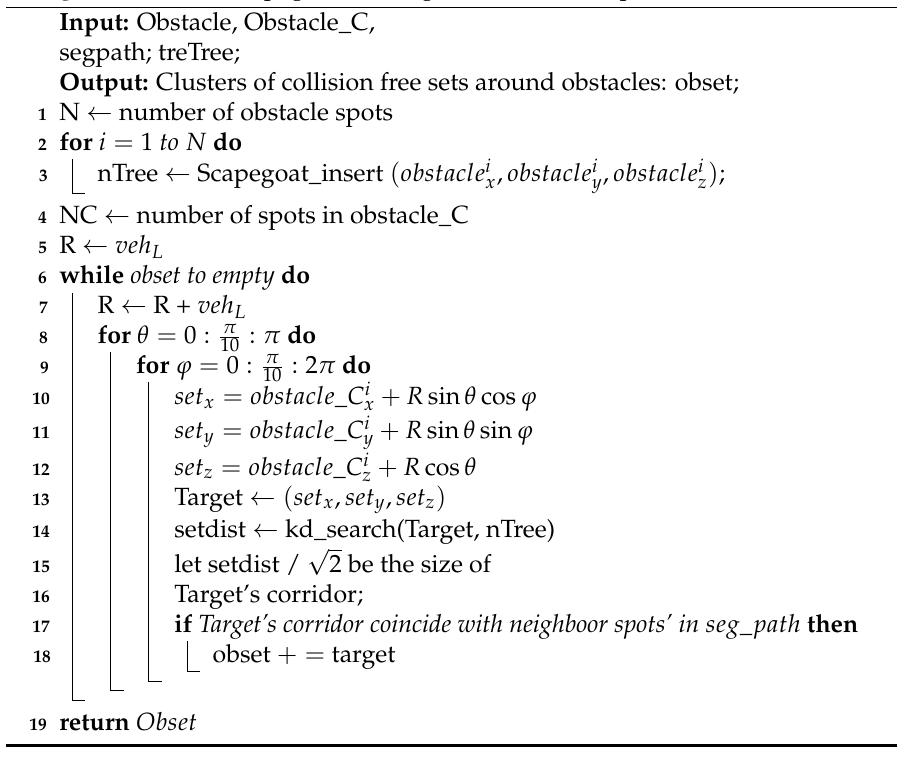
Algorithm 3: Use scapegoat tree to get collision-free spots around obstacles.